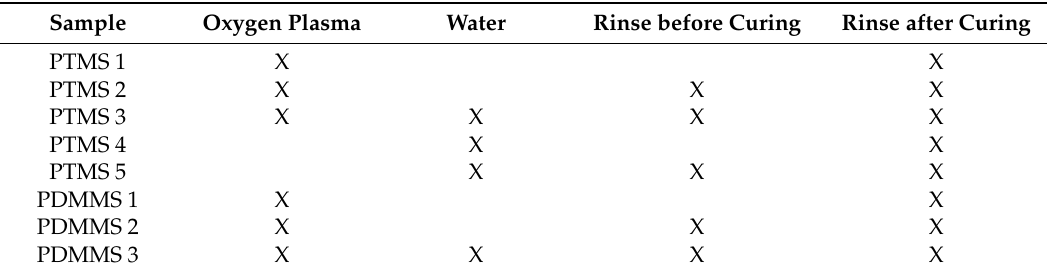
Table 1. Treatment steps applied to each propyltrimethoxysilane (PTMS) and propyldimethylmethoxysilane (PDMMS)